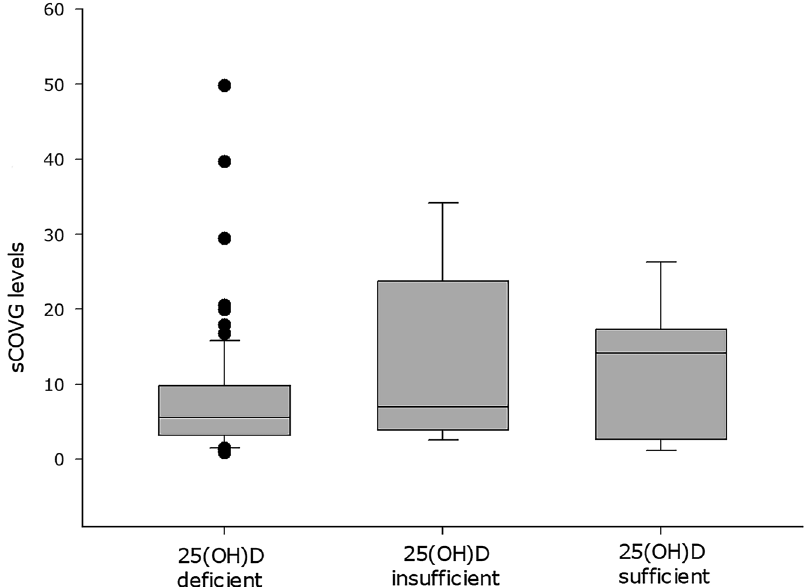
Figure 1: Comparison of SARS-CoV-2 IgG (sCOVG) index levels of patients with 25-hydroxyvitamin D [25(OH)D] de fi ciency, insuf fi ciency, and suf fi ciency. Data are presented as median and interquartile ranges.